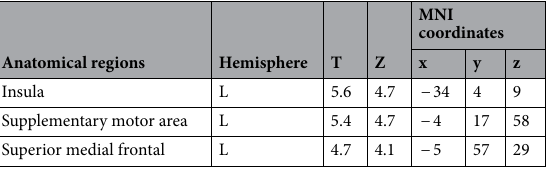
Table 5. Brain regions showing increased Cortical Gyrification in Pandits/Priests compared with control (Pandit > control).